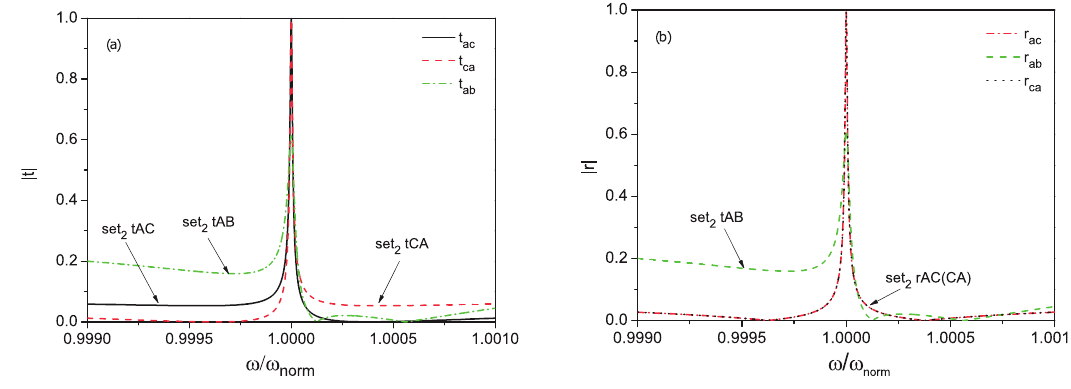
Figure 2. Transmission ( a ) and reflection ( b ) coefficients for the four-port router with the following parameters: β = 3.4, L side = 0.028, L 12 = 2 π , Θ N is set to 5 GHz, Γ central = 10 MHz. The sets are described in Table 1.